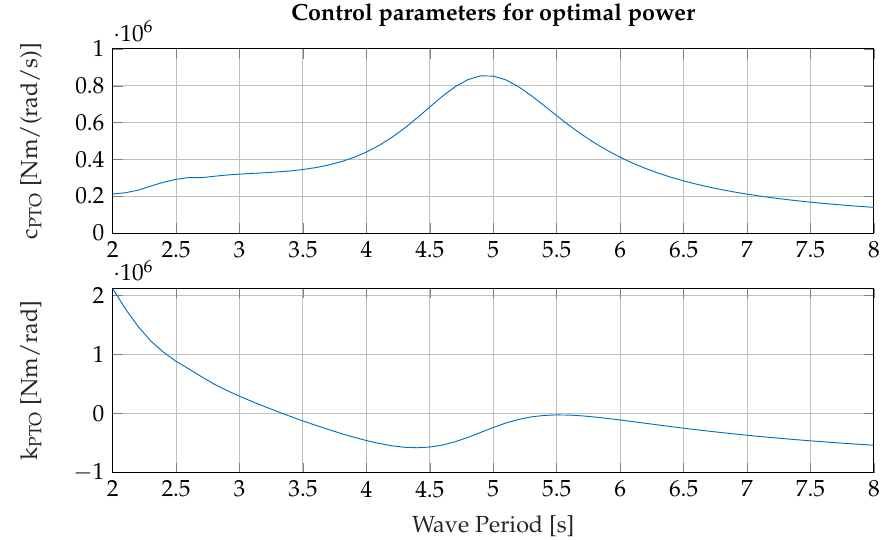
Figure 7. Damping and spring constants to achieve resonance and maximum power at different wave